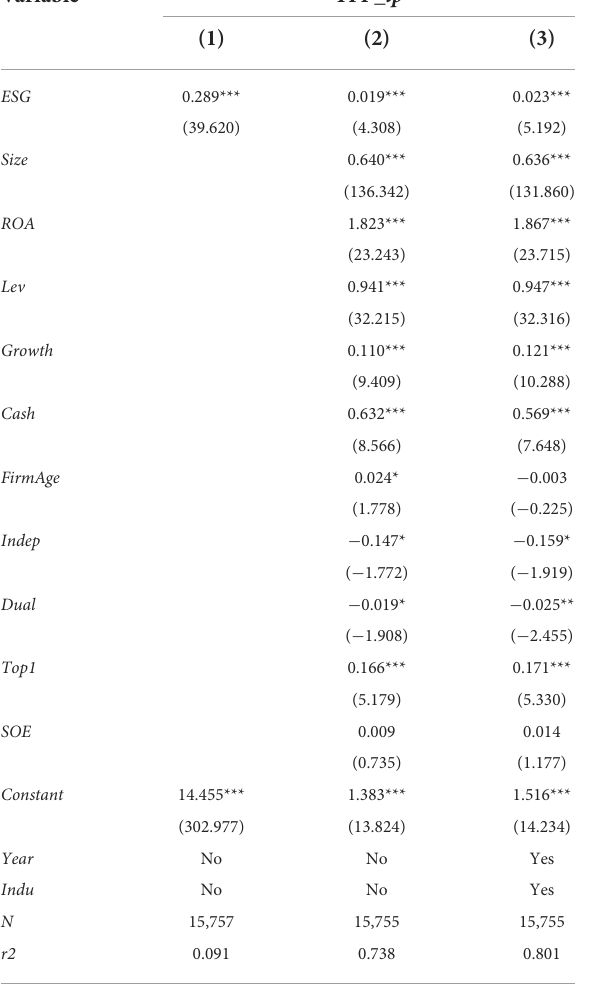
TABLE 2 The effect of environmental, social, and corporate governance (ESG) on total factor productivity (TFP). Variable